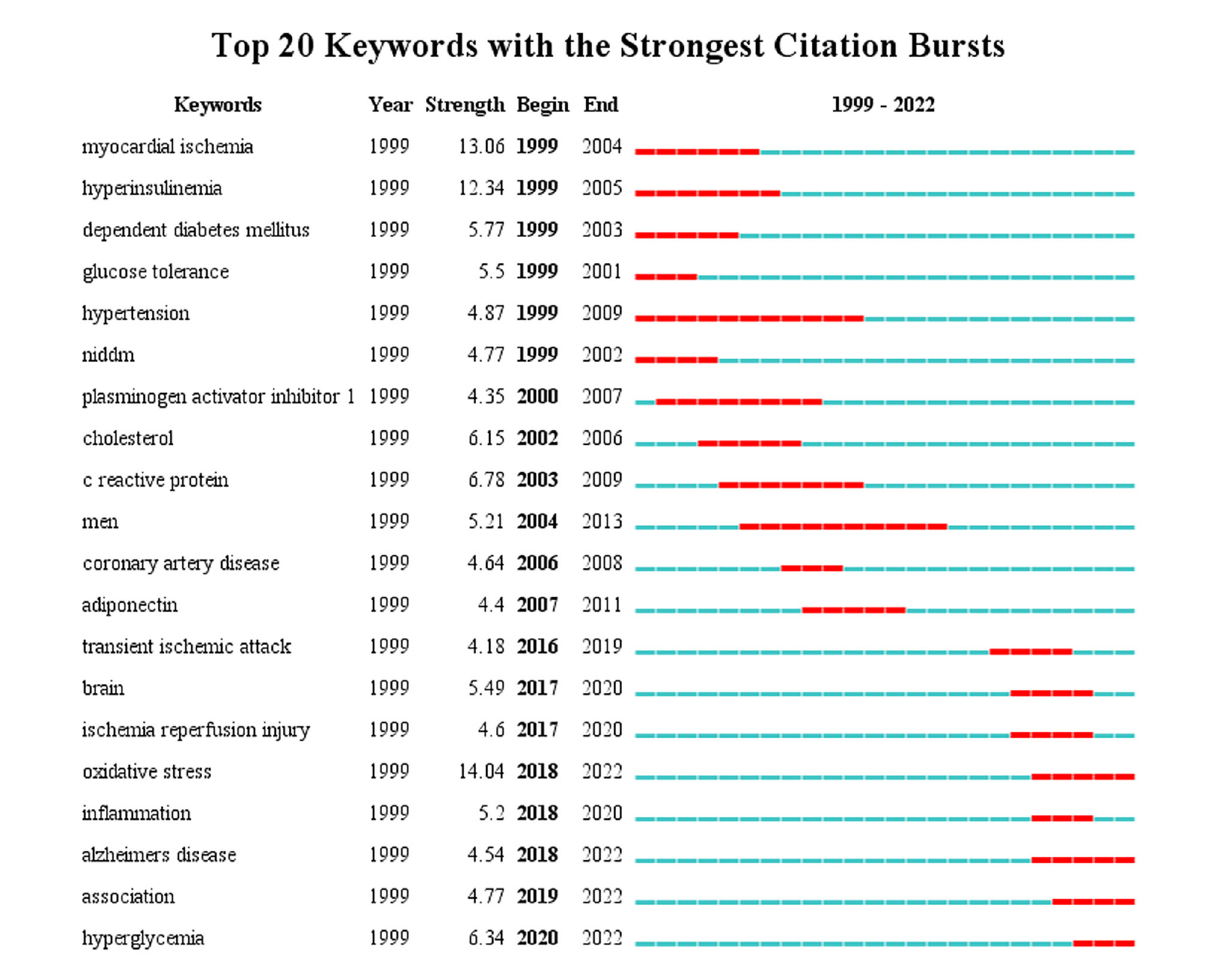
FIGURE7 Top 20 keywords with the strongest citation